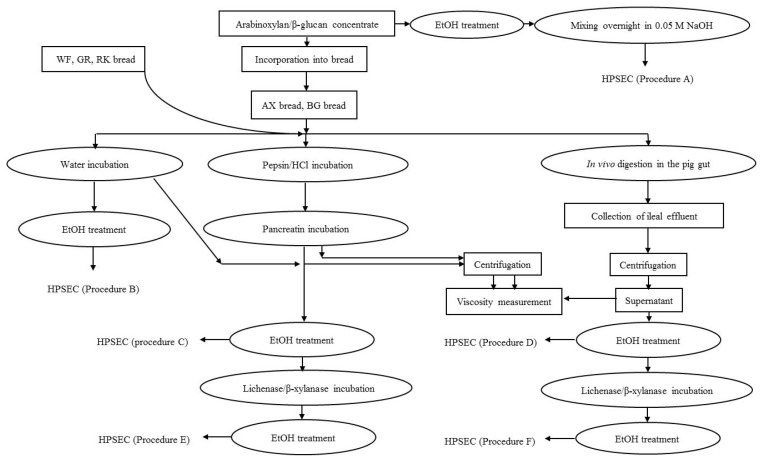
Overview of extraction, purification and sampling from fiber concentrates, bread extracts, and in vitro and in vivo digested bread for molecular weight determination.